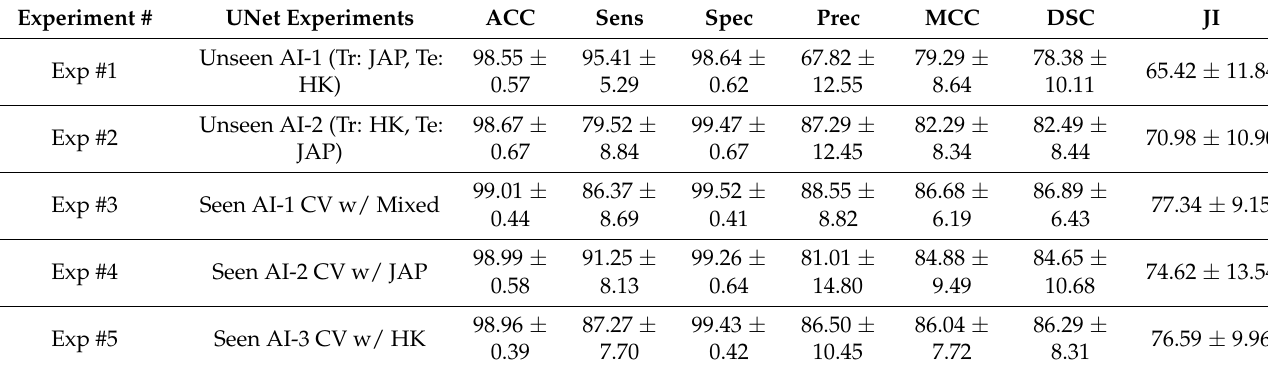
Table 2. Classification parameters of the test dataset of all experiments.